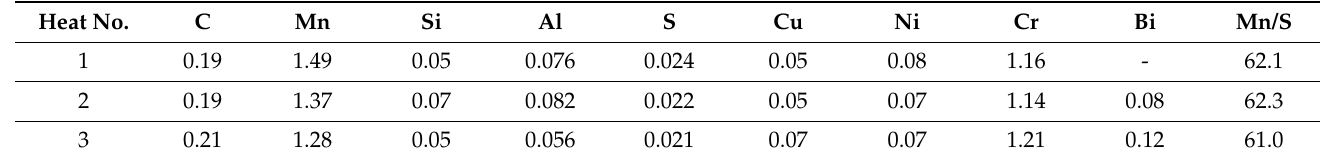
Table 1. Chemical composition of the CMnCr steels [wt. %].